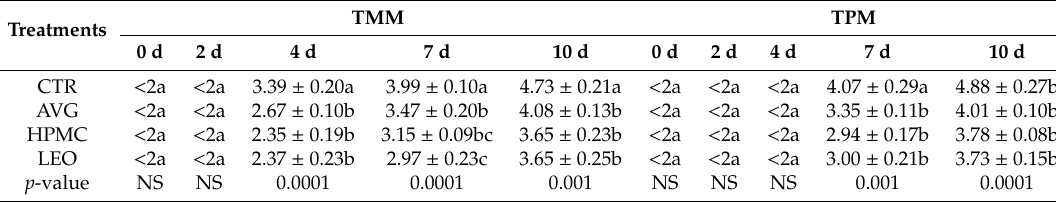
Table 2. Total mesophilic and psychrotrophic bacterial loads of the fruit samples.